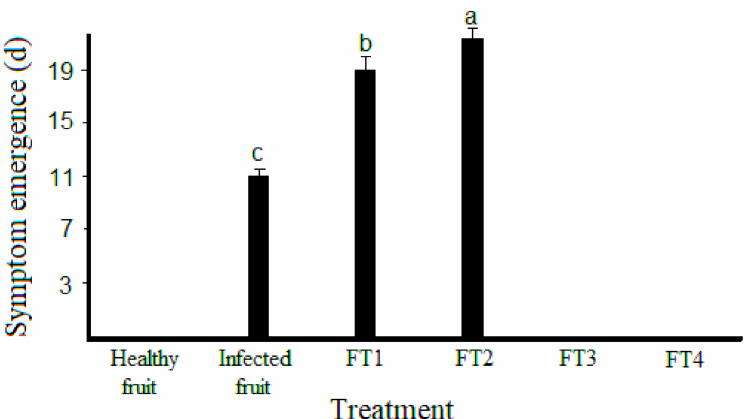
Figure 3. Quantitative delaying effect of the hybrid films FT1–FT4 on the emergence of soft rot symptom in avocadoes triggered by Clonostachys rosea . Bars with different letters indicate means with statistically significant differences ( p < 0.01). Avocadoes treated with the films FT3 and FT4 did not show rot symptoms after 21 d